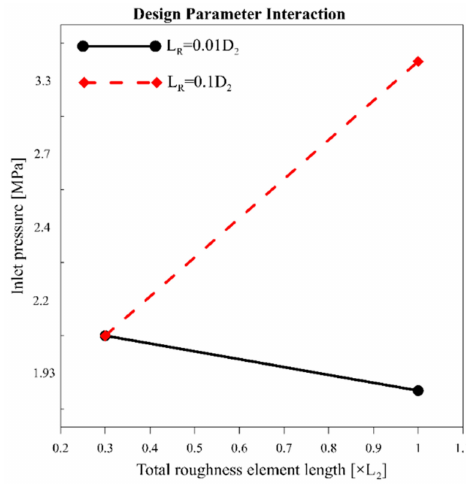
Figure 7. Design parameters interaction plot showing an intense interaction between the wall roughness elements and geometrical